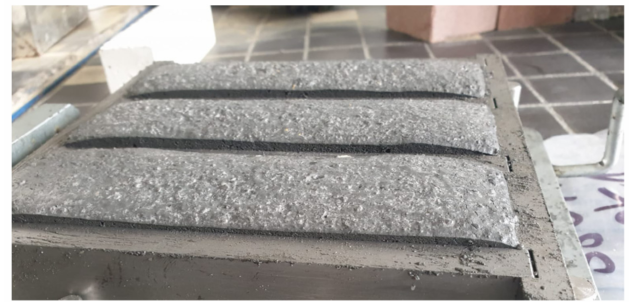
Figure 9. Swollen sample with MSWIBA without NaOH